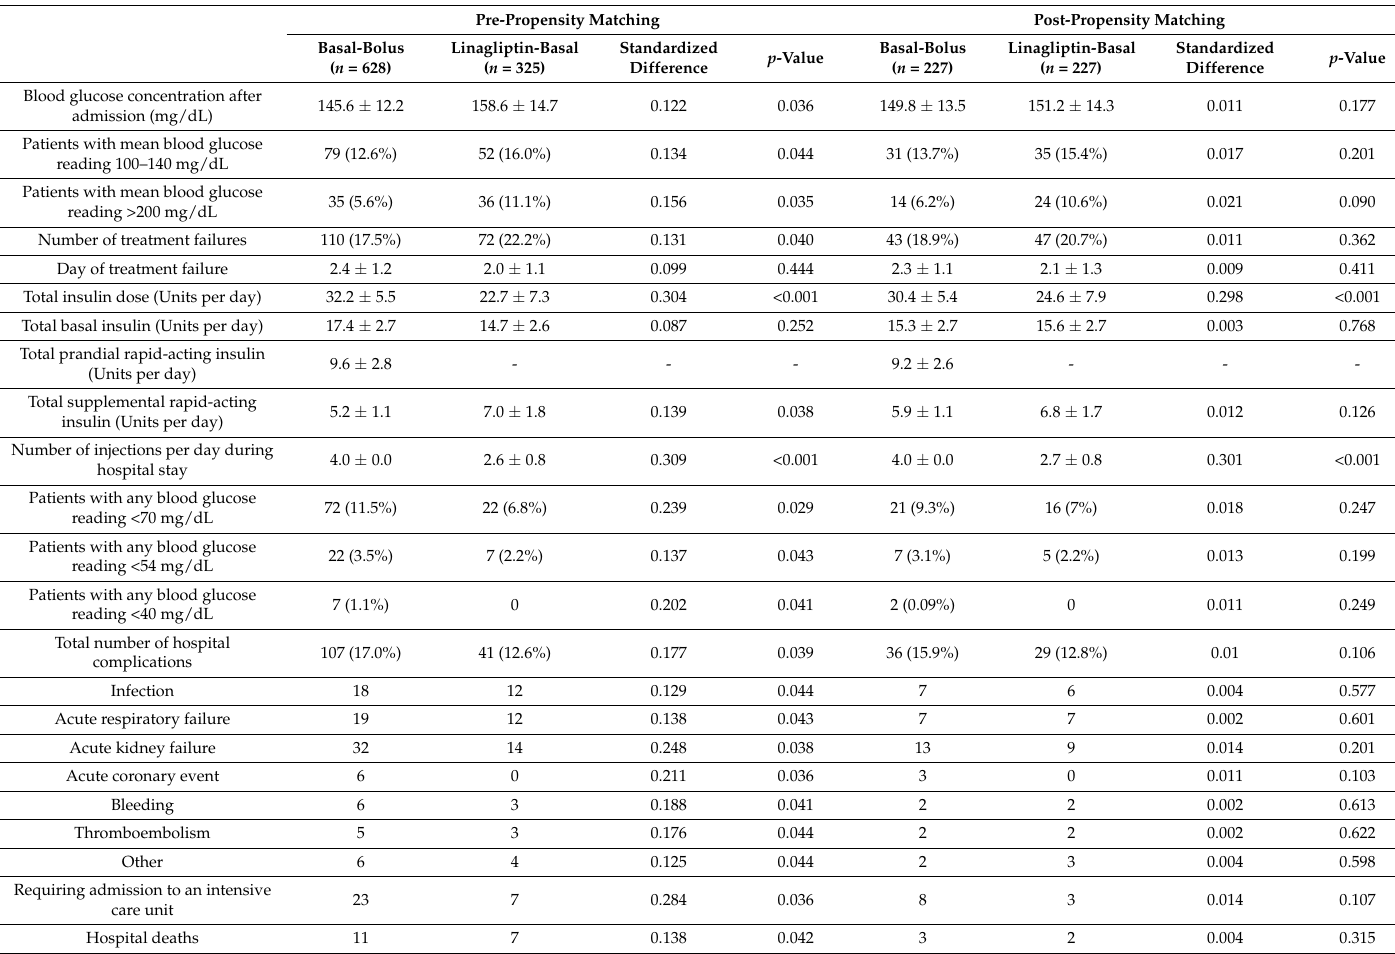
Table 3. Pre- and post-propensity matching glycaemic control outcomes, treatment failures, insulin doses, hypoglycaemic events and hospital complications of hospitalized patients with type 2 diabetes grouped by hospital antidiabetic